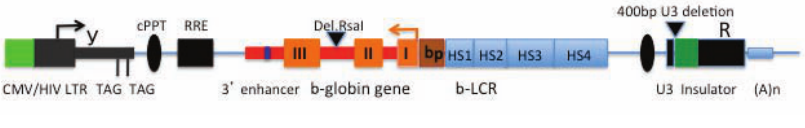
Figure 9. General scheme of 3rd generation globin lentiviral vectors. Vectors have dele- tions of all dispensable and potentially harmful HIV sequences (tat, vif, vpr, vpu, nef). The partial ORF of GAG that can not be removed because overlaps the packaging signal (Y) contains 2 in frame stop codons. The 400 bp deletion in the U3 region blocks provirus transcription after chromosomal integration (self inactivating vector). POL- GAG , REV and VSV-G envelopes are provided in trans to avoid recombination that could reconstitute wild type replication competent HIV particles. The b-globin cassette in the current vectors contains from 2 to 4 HSs, β -globin promoters of 260-600 bp, a stabiliz- ing RsaI deletion of IVS2, variable length of the 3’ UTR and an enhancer region con- tained in a PstI fragment 3’ to the β -globin gene. As an additional safety feature some vector are insulated with the chicken HS4 or other equivalent insulator. Insulators that are inserted into the 3’ U3 region are duplicated and moved to the 5’ U3 region during viral reverse transcription achieving insulation of both sides of the vector. Insulation is expected to restrict the activity of the internal LCR enhancer to the globin cassette and to create a barrier to the invasion of adjacent heterochromatin that ensures persistent expression. ORF, Open reading frame; GAG, group-specific Antigen; 3’ UTR, 3’ untrans- lated region; LCR, locus control